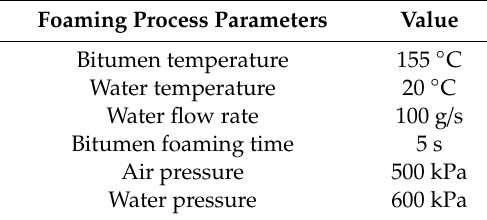
Table 3. Bitumen foaming